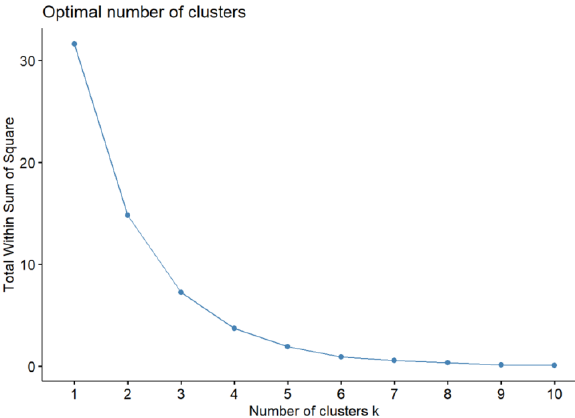
Figure 6: Left: "Scree" plot used to identify the optimal